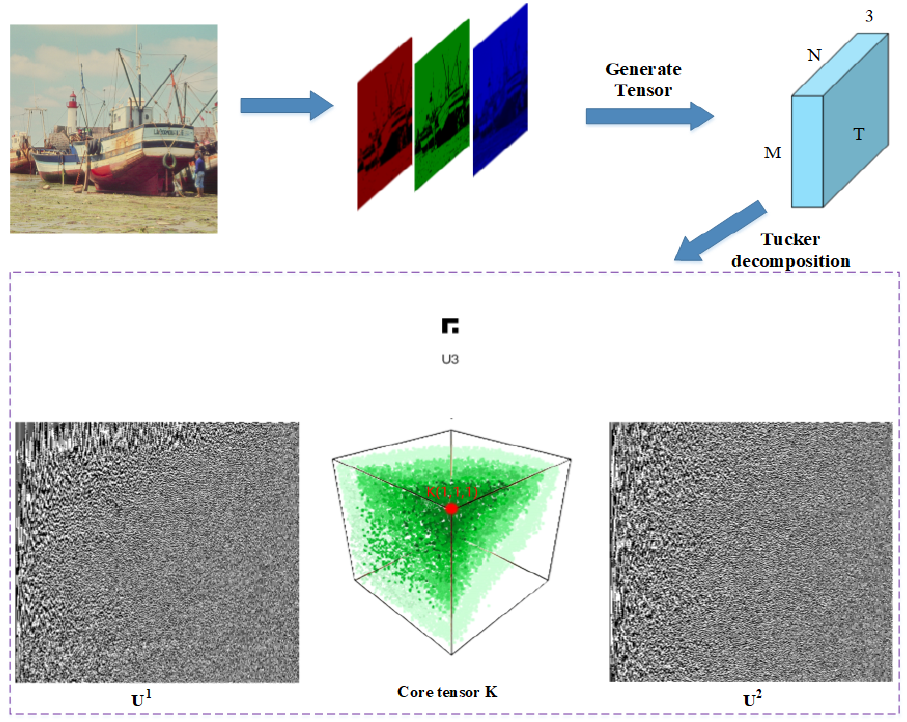
Figure 3. Flowchart for Tucker